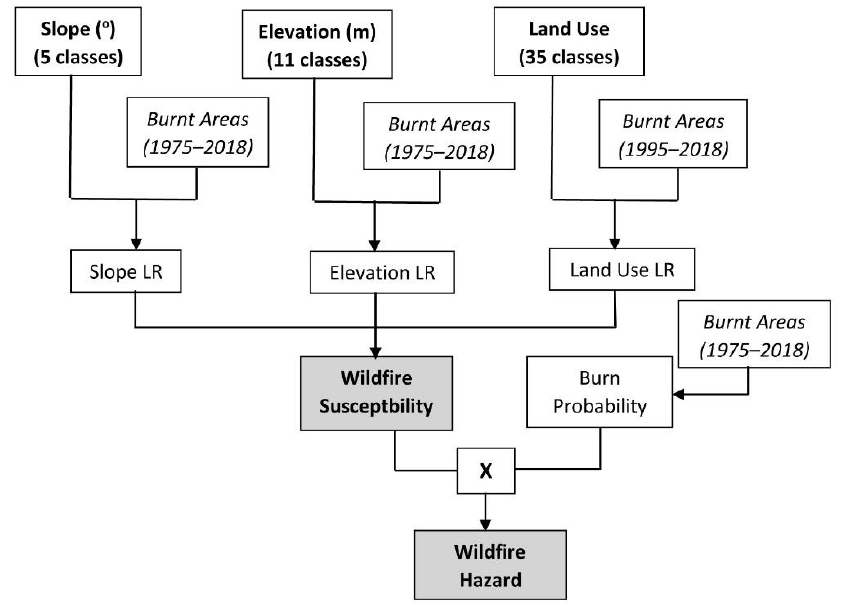
Figure 4. A schematic representation of the methodology used to produce the wildfire hazard